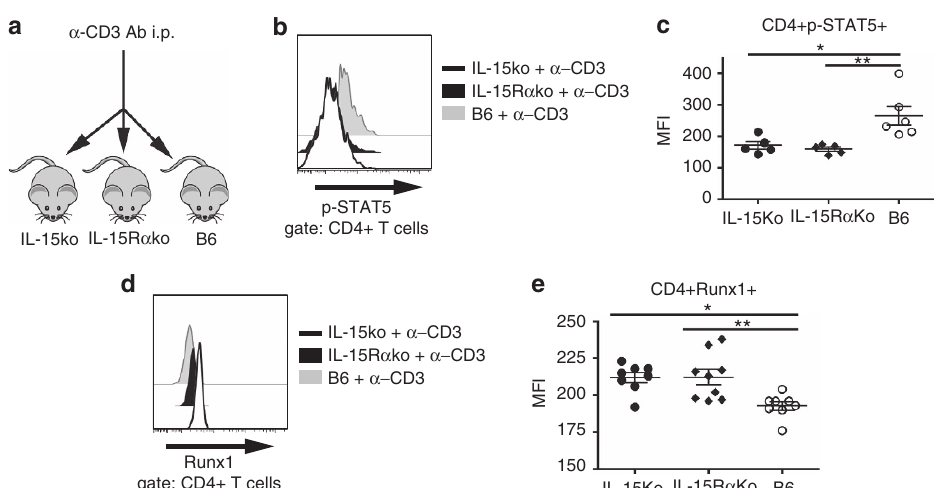
Figure 7 | CD4 þ T cells with impaired IL-15 signaling respond to TCR stimulation by down-regulation of pSTAT5 and up-regulation of Runx1. ( a ) IL-15ko, IL-15R a ko (IL-15 receptor alpha deficient) and B6 mice received i.p. 50 m g a -CD3 Ab and were killed 2h later. ( b ) Expression of p-STAT5 (phosphorylated signal transducer and activator of transcription 5) on CD4 þ Tcells in the LN sampled from the injected mice and re-stimulated 20min in vitro with recombinant mouse (rm) IL-15. ( c ) Median fluorescence intensity (MFI) of p-STAT5 expression on CD4 þ T cells isolated from the injected mice and re-stimulated 20min in vitro with rmIL-15. ( d ) Expression of Runx1 (runt-related transcription factor-1) in CD4 þ Tcells isolated from the LN of IL- 15ko, IL-15R a ko and B6 mice 2h after injection of a -CD3 Ab. ( e ) MFI of Runx1 expression on CD4 þ T cells isolated from the injected mice. Black line: IL-15ko, black shadow: IL-15R a ko, grey shadow: B6. Black circles: IL-15ko, black diamonds: IL-15R a ko, open circles B6. ( b – e ) Data compiled from two separate experiments with at least two mice per group. Each symbol represents an individual mouse. One-way analysis of variance ( P o 0.01), Tukey’s post-test values: * P o 0.05; **0.01 o P o 0.05.